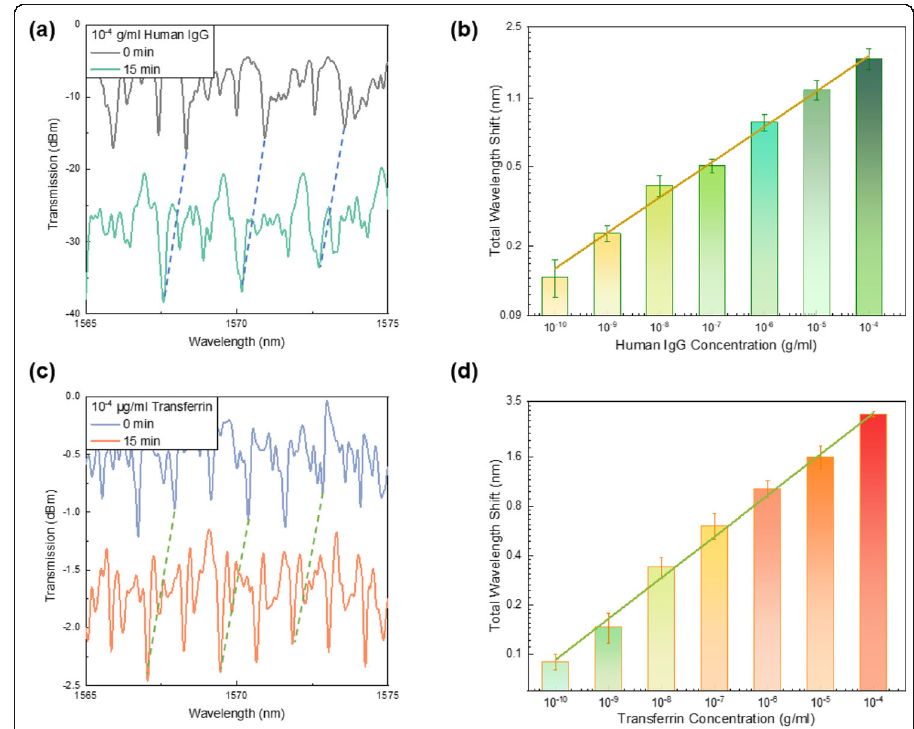
Fig. 5 WGM laser spectra of the LC-amplified optofluidic resonator under 10 − 4 g/ml ( a ) human IgG and ( c ) transferrin at 0 min and 15 mins. The overall wavelength shift responses under different concentrations of